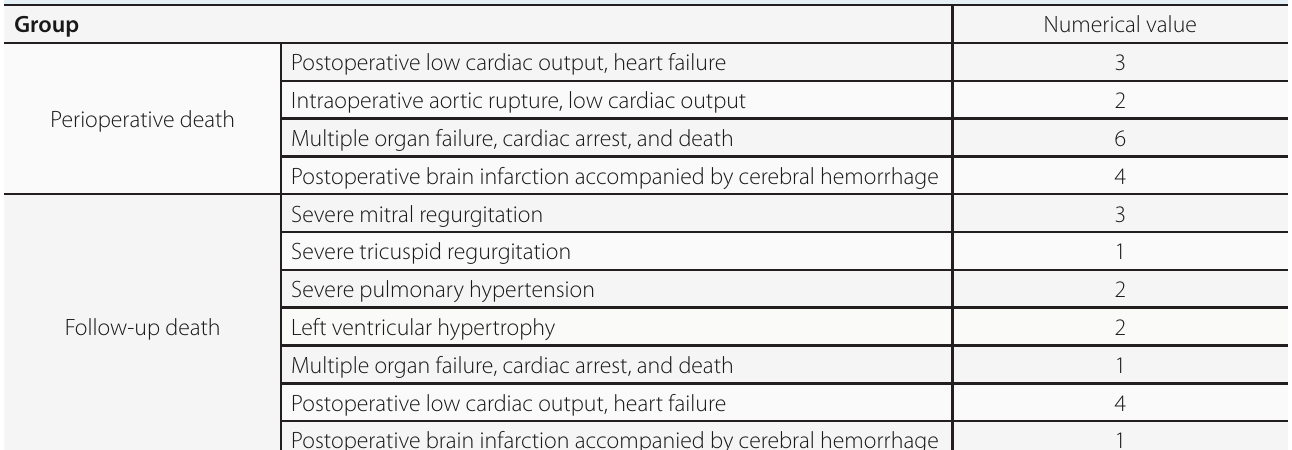
Table 3. Perioperative and follow-up death. Group